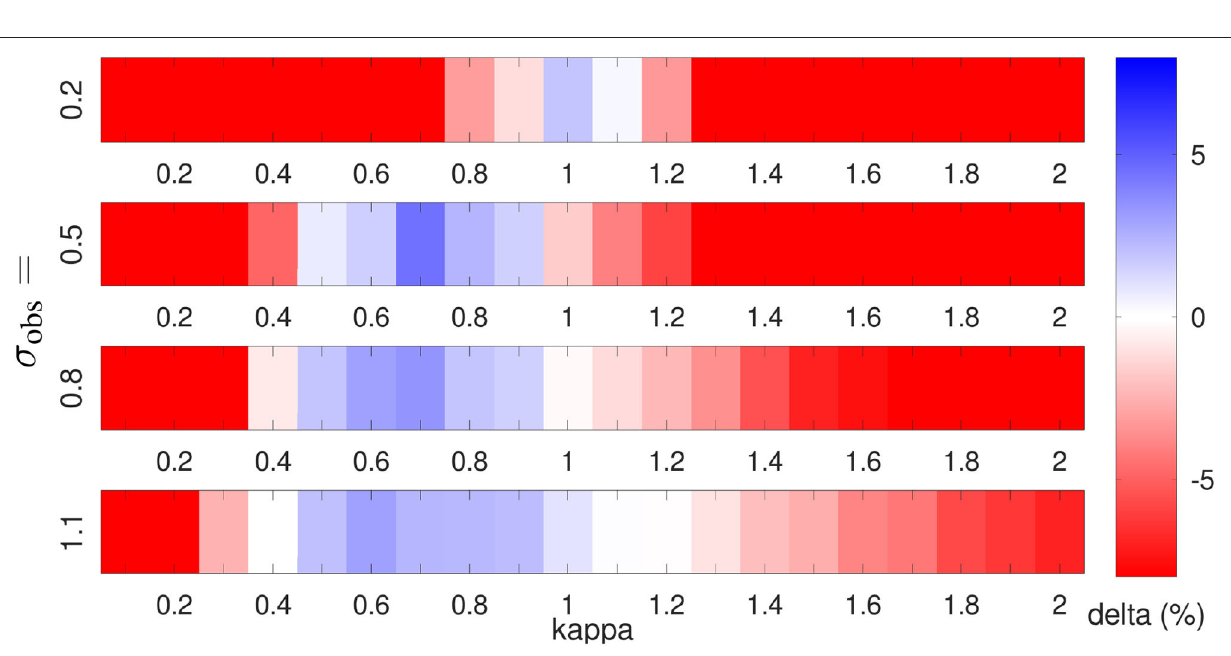
FIGURE 8 | The background errors of LMCPF and LETKF following Equation (121) are compared for different observation error standard deviations σ obs . Positive values denote a smaller RMSE of truth minus background for the LMCPF method than the LETKF. For each parameter combination, 1,000 data assimilation steps for the Lorenz 1996 model are carried out whereas the last 900 steps are used to compute the statistics. The experiments are repeated ten times with different seeds and the average error is reported. The true trajectory is generated with F true 8 and the integration of the ensemble of states is performed with F 8.5. The forecast = = length is set to 1 t 0.5. Every second variable is observed. The ensemble size is set to L 20 for both = =